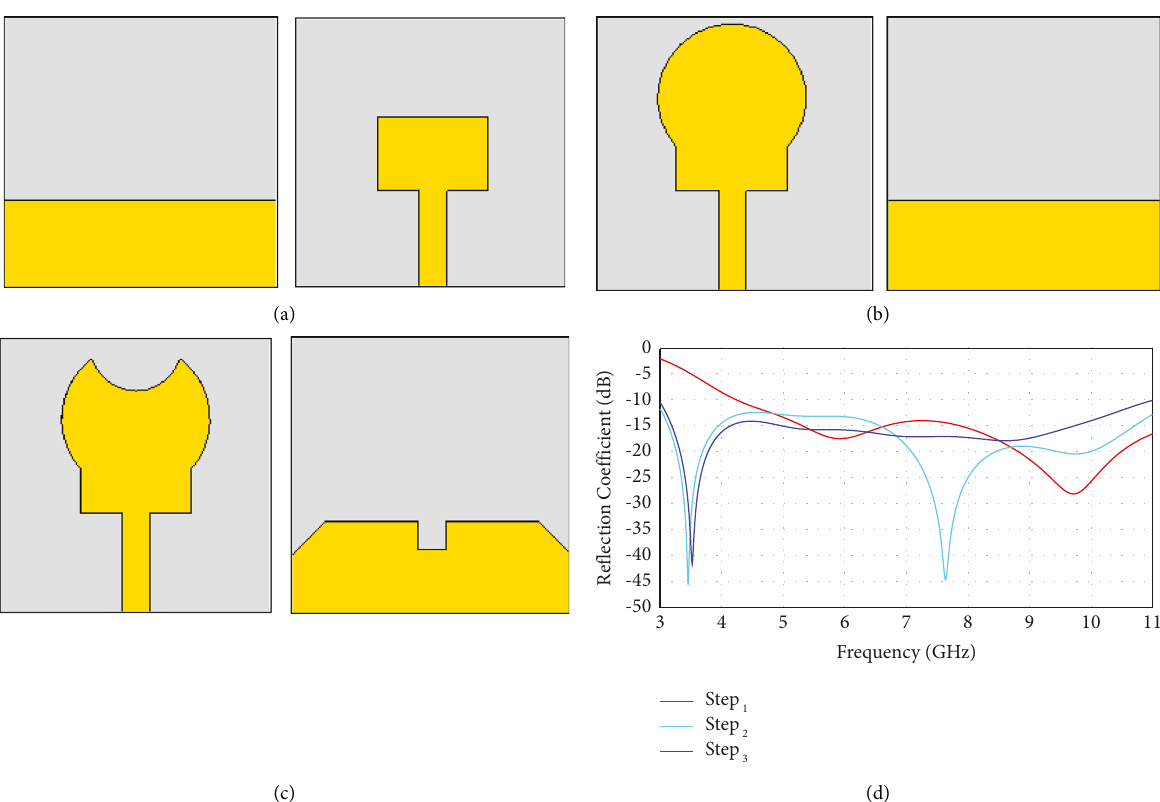
Figure 2: (a–c) Stepwise antenna design progress. (d) Simulated reflection coefficient for all design steps.